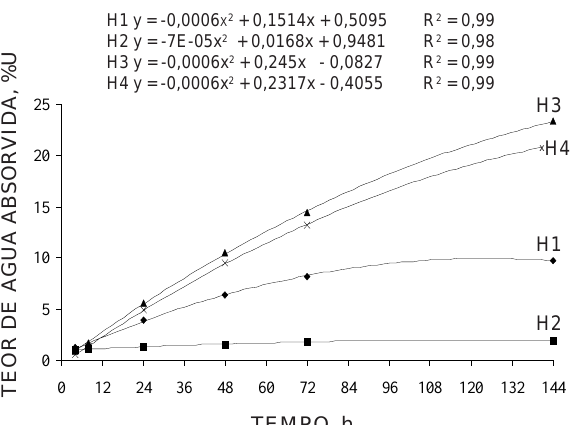
Figura 5. Valores médios de absorção de água (U%) pelas misturas de fertilizantes, considerando o tempo de exposição à umidade relativa de 78,1 %